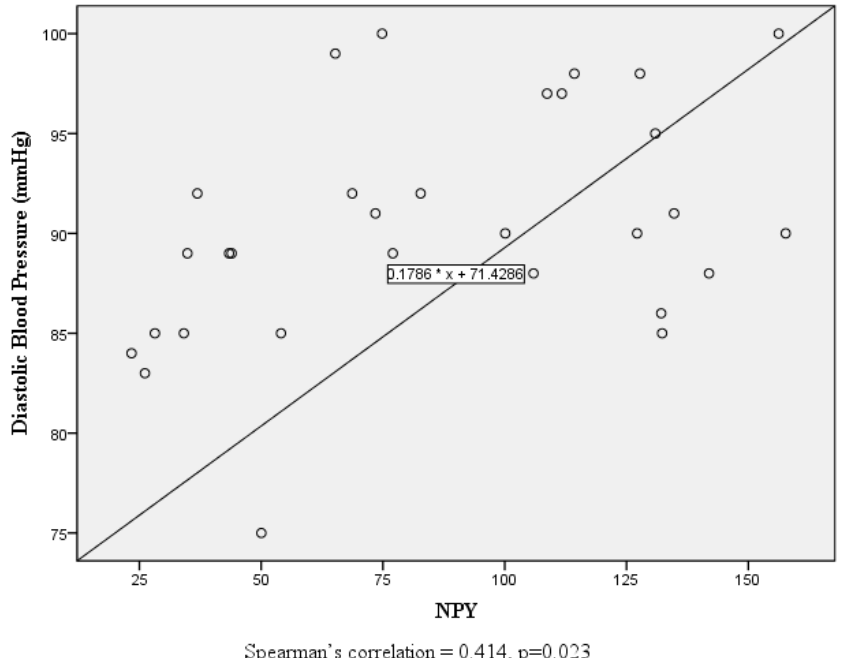
Figure 4. Scatter plot and correlation between diastolic blood pressure and serum neuropeptide Y levels post intervention.